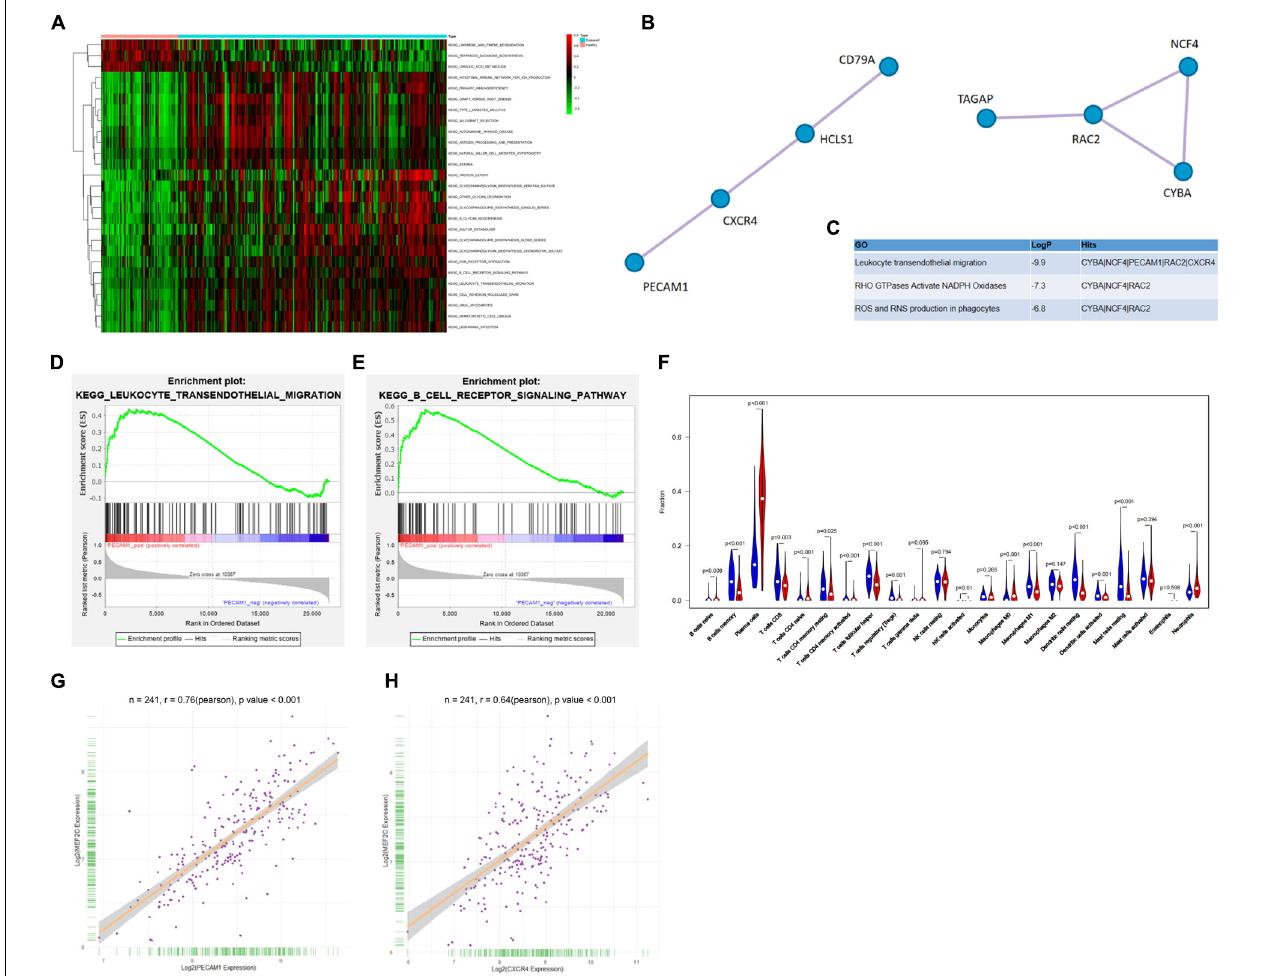
FIGURE 1 | PECAM1 and CXCR4 are highly expressed in the inflamed dental pulp tissues. (A) Aberrantly activated signaling pathways in the inflammatory dental pulp tissues predicted by GSVA. (B–C) The interacted proteins with PEACM1 and the highly correlated genes predicted by PPI analysis. (D–E) Enrichment of signaling pathways based on the differentially expressed genes predicted by GSEA. (F) Concentration of 22 types of immune cells in each sample determined using an R/Cibersort Package. (G–H) Predicted binding sites between MEF2C with CXCR4 and